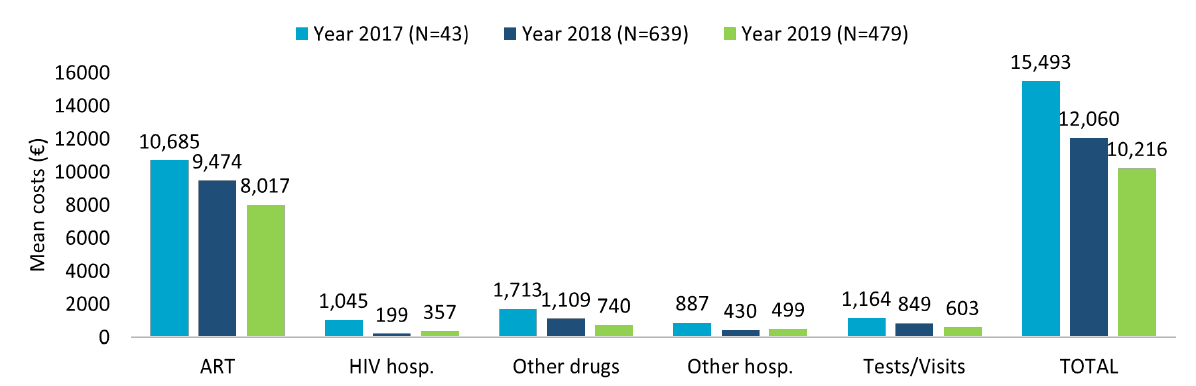
Figure 1. Mean annual health care costs (EUR) in patients with TAF-based regimen during first year of follow-up for the inclusion years 2017 – 2018 – 2019.